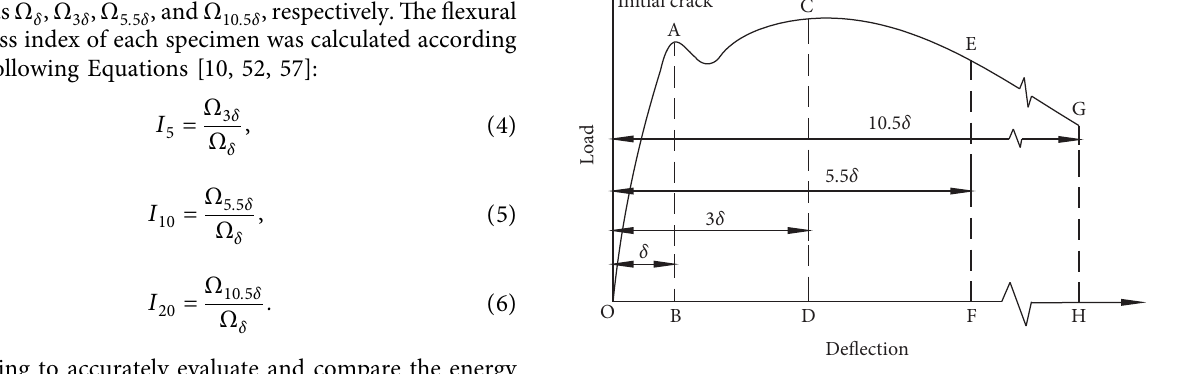
Figure 4: Computing models of fexural toughness index of